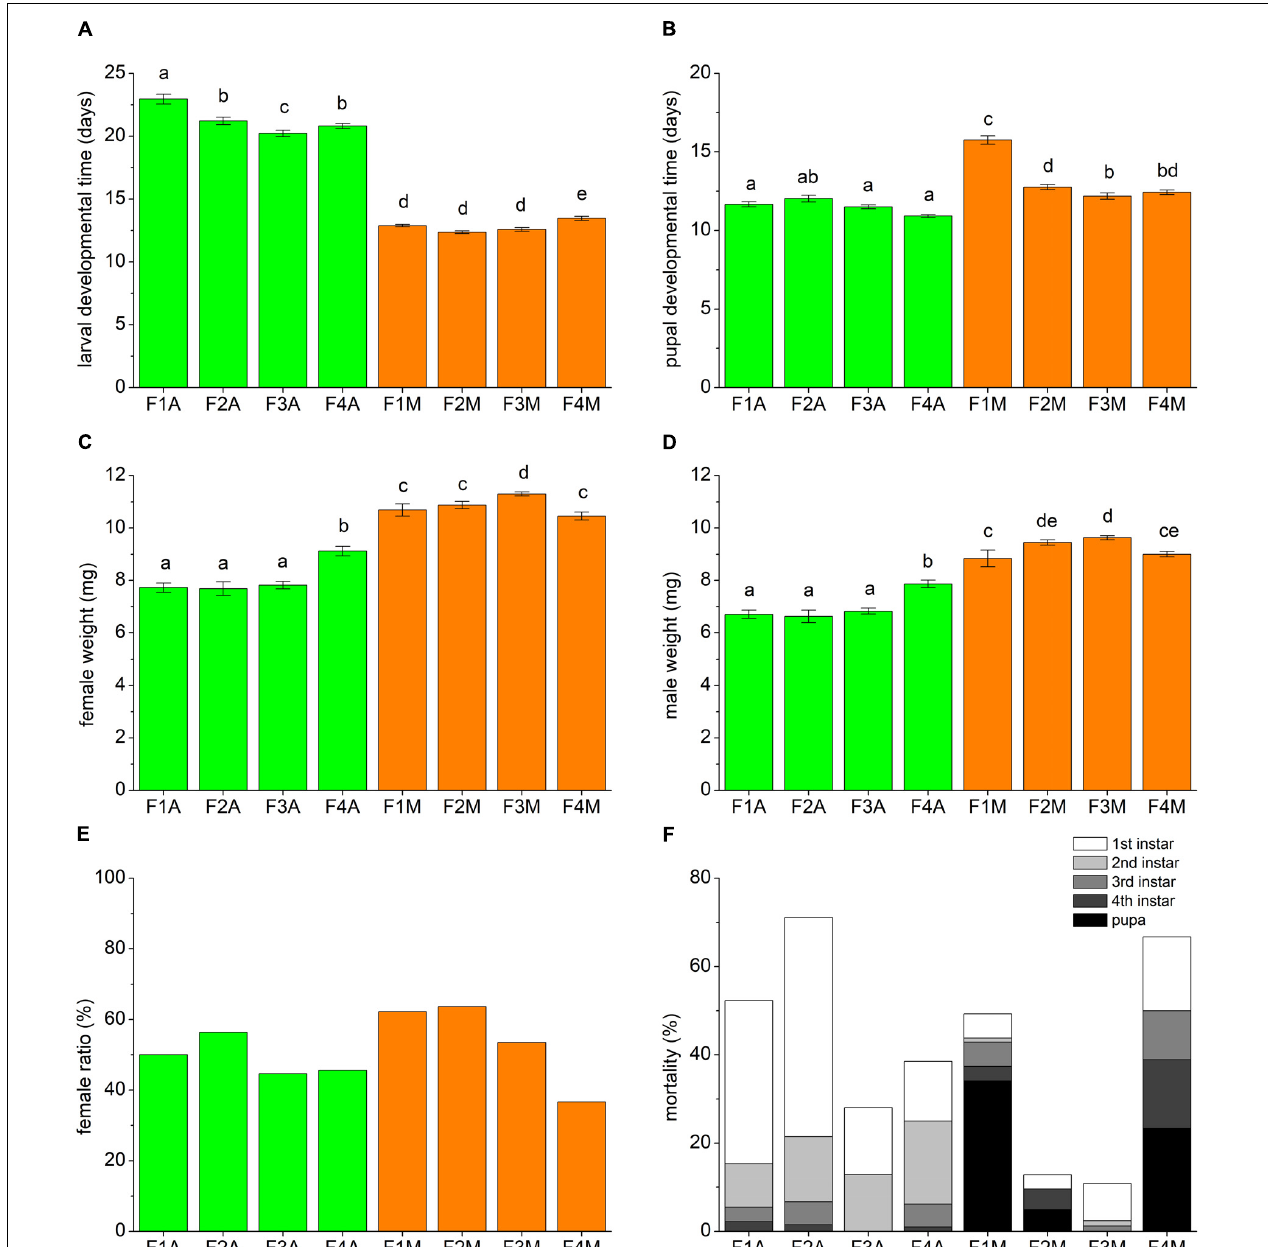
FIGURE 2 | Developmental traits of each line, including (A) the larval developmental time, (B) the pupal developmental time, (C) the female weight, (D) the male weight, (E) the female ratio, and (F) the mortality rate. Approximately 100 freshly hatched larvae of each line were tested. Bars (mean ± standard error of mean) with the same letter are not significantly different ( p ≥